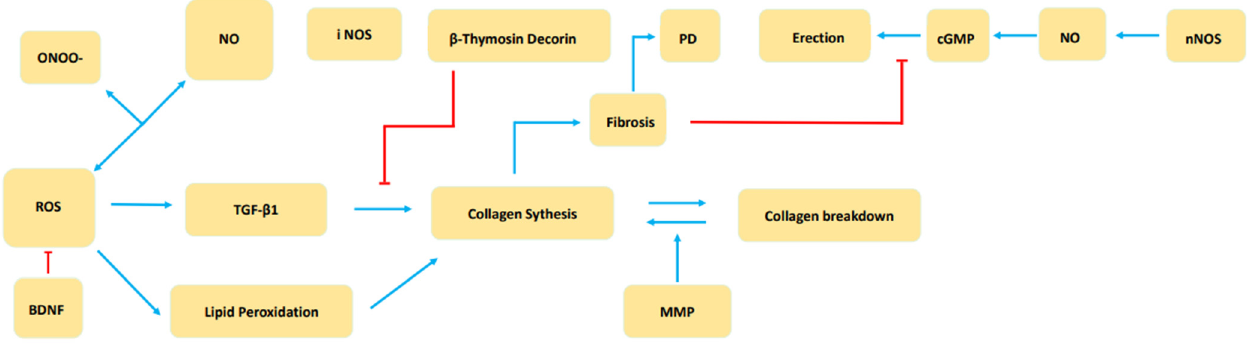
Figure 2. Schematic diagram of the effect of ROS on the progression of fibrosis.